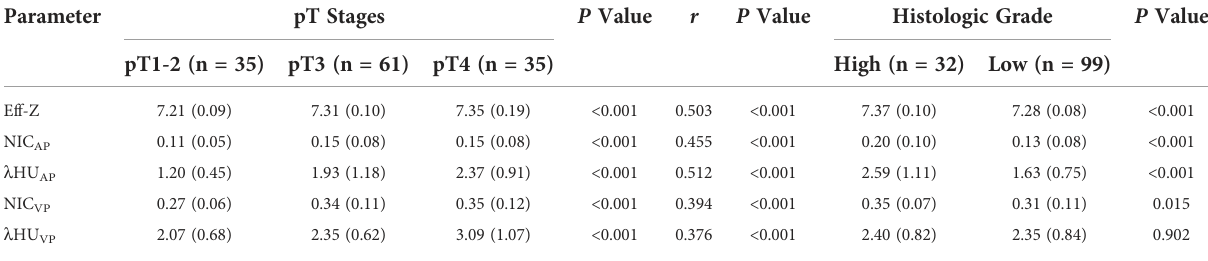
TABLE 3 Comparison DLCT parameter values between different pT stages and histologic grades, and the correlations with pT stages.